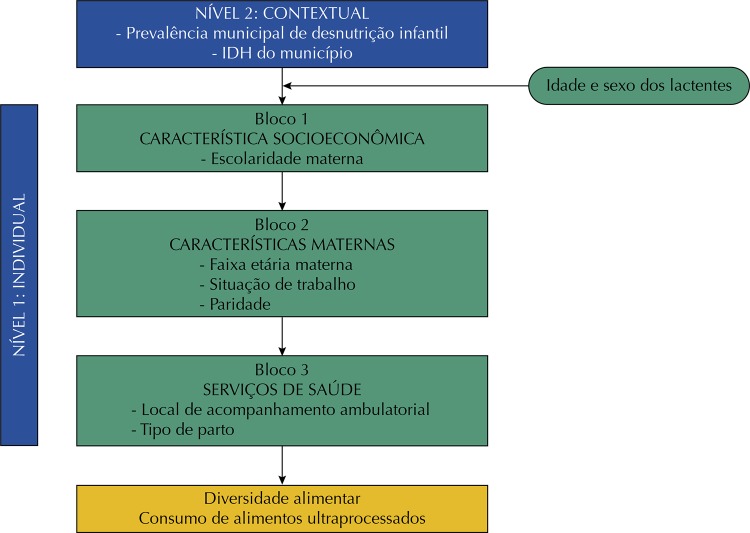
Marco conceitual para investigação dos fatores individuais e contextuais da diversidade alimentar e do consumo de alimentos ultraprocessados.IDH: índice de desenvolvimento humano